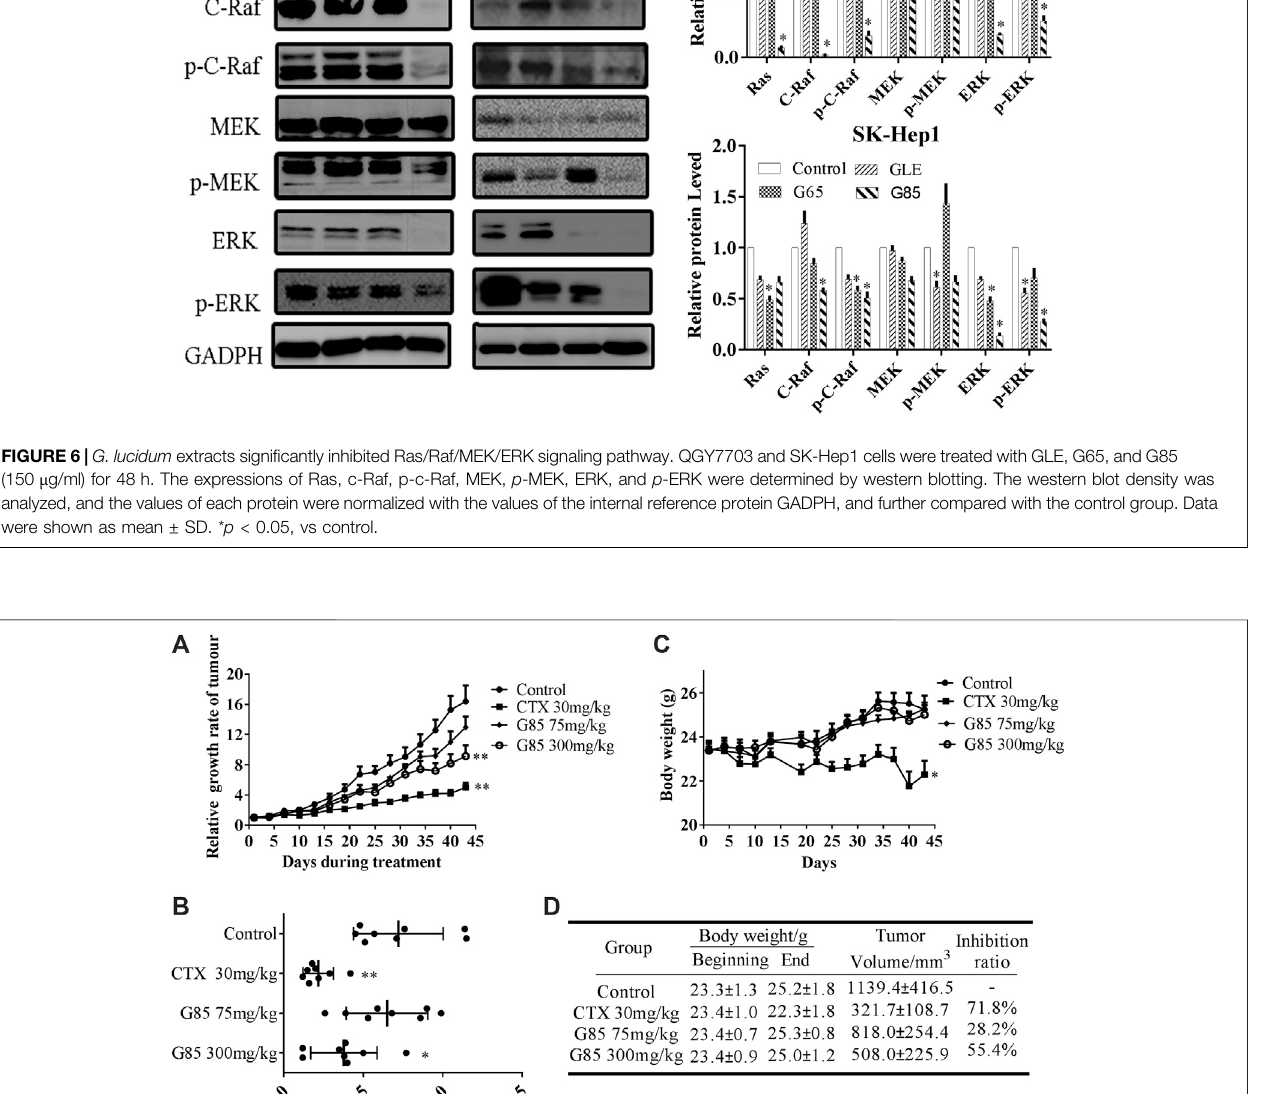
Frontiers in Pharmacology |